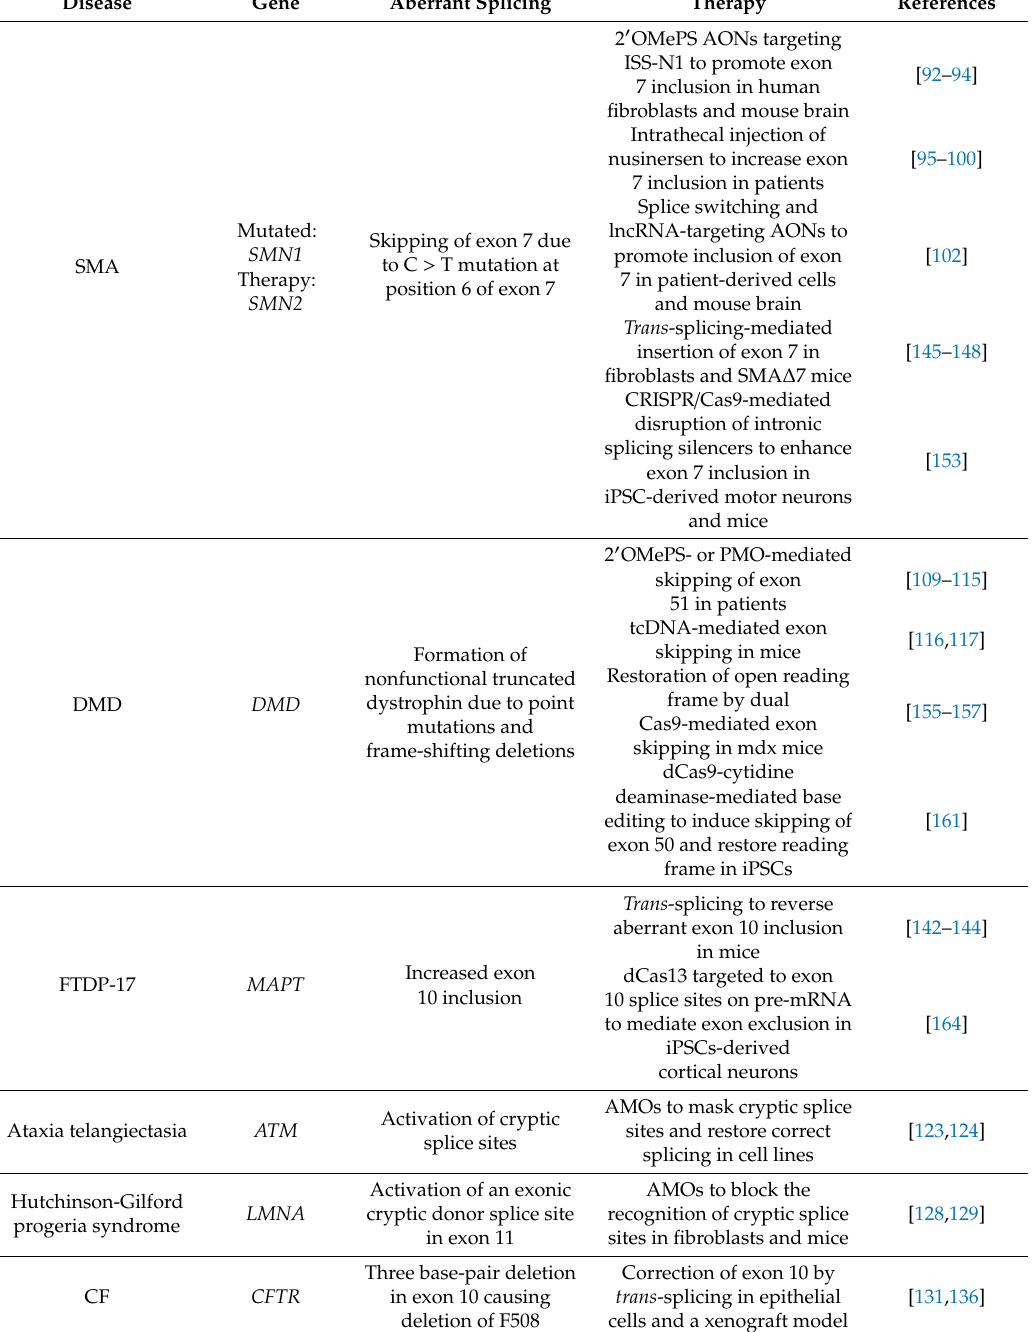
Table 2. Examples of Splicing-based Therapeutic